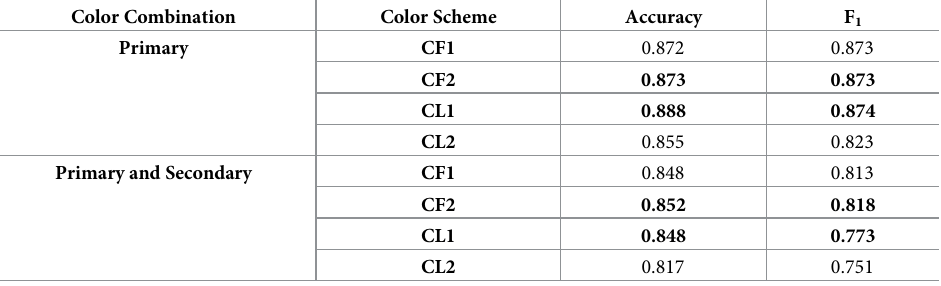
Table 4. Accuracy and F 1 for the multi-class